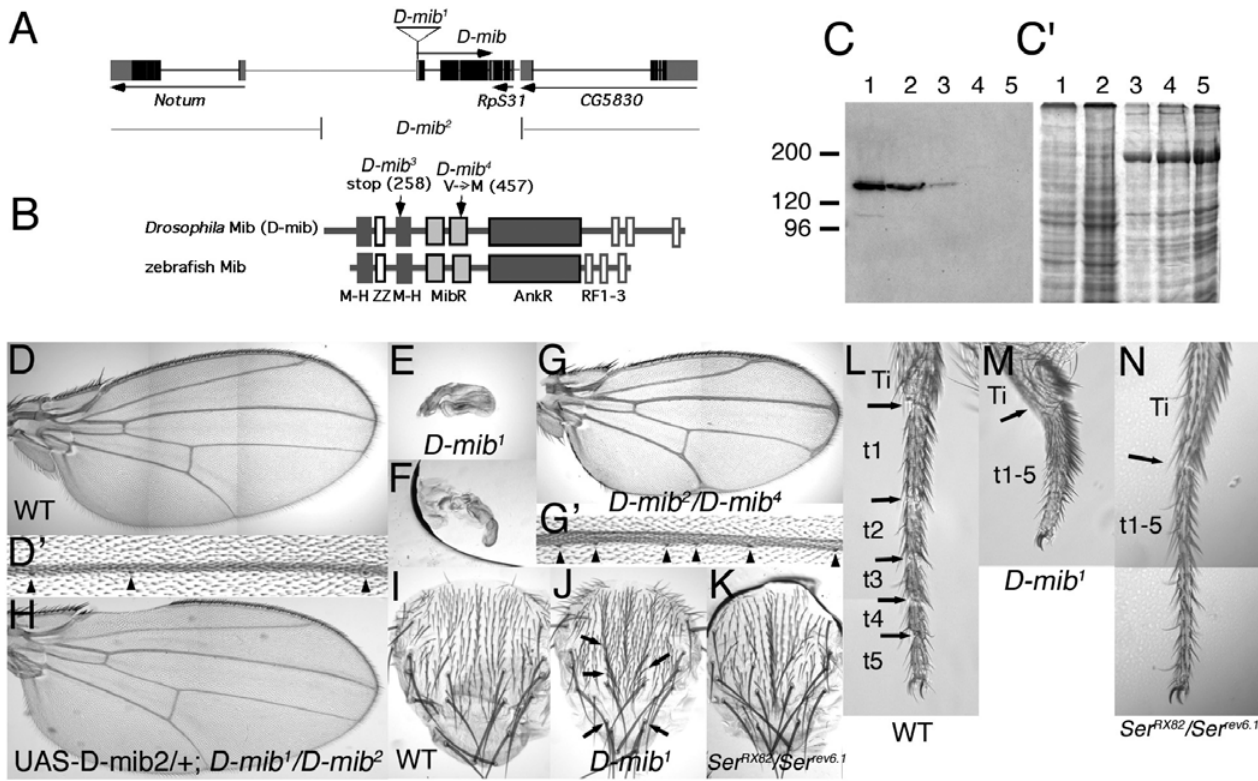
Figure 1. Molecular and Genetic Characterization of D-mib Mutations (A) Molecular map of the D-mib locus showing the position of the P-element inserted into the 5 9 untranslated region (allele D-mib 1 ) and the 13.6 kb deletion that removes the D-mib and the RpS31 genes (allele D-mib 2 ). Transcribed regions are indicated with arrows, and exons are indicated with boxes. Open reading frames are shown in black. (B) Domain composition of D-mib and D. rerio Mib. Both proteins show identical domain organization. D-mib has an N-terminal ZZ zinc finger flanked on either side by a Mib/HERC2 (M-H) domain, followed by two Mib repeats, six ankyrin repeats, two atypical RING domains, and a C-terminal protypical RING that has been associated with catalytic E3 ubiquitin ligase activity. The D-mib 3 mutant allele is predicted to produce a truncated protein devoid of E3 ubiquitin ligase activity whereas the D-mib 4 protein carries a mutation at a conserved position in the second Mib repeat. (C and C 9 ) Western blot analysis of D-mib (C). The endogenous D-mib protein (predicted size: 130 kDa) was detected in S2 cells (lane 2) and in imaginal discs from wild-type larvae (lane 3) but was not detectable in homozygous D-mib 1 (lane 4) and D-mib 1 /D-mib 3 (lane 5) third instar larvae. The D-mib protein produced in transfected S2 cells from the cDNA used in this study (lane 1) runs exactly as endogenous D-mib (lane 2). Panel C 9 shows a Red Ponceau staining of the gel with the same protein samples as in panel C. (D–H) Wings from wild-type (D), D-mib 1 (E), Ser RX82 /Ser rev6.1 (F), D-mib 2 /D-mib 4 (G), and UAS-D-mib 2 / þ ; D-mib 1 /D-mib 2 flies (H). D-mib (E) and Ser (F) mutant flies showed similar wing loss phenotypes. The D-mib mutant phenotype could be almost fully rescued by a leaky UAS-D-mib transgene (H). (D 9 ) and (G 9 ) show high magnification views of (D) and (G), respectively, to show that D-mib 2 /D-mib 4 mutant flies (G 9 ) exhibited ectopic sensilla (arrowheads) along vein L3. (I–N) Nota (I–K) and legs (L–N) from wild-type (I and L), D-mib 1 (J and M), and Ser RX82 /Ser rev6.1 (K and N) flies. D-mib mutant flies showed a weak neurogenic phenotype (J) that was not observed in Ser mutant flies (K). Ectopic sensory organs in D-mib mutant flies developed from ectopic sensory organ precursor cells (not shown). D-mib (M) and Ser (N) mutant legs also showed distinct growth and/or elongation defects. Arrows in (J) show ectopic macrochaetes. Arrows in (L–N) indicate the joints. Ti, tibia; t1 to t5, tarsal segments 1 to